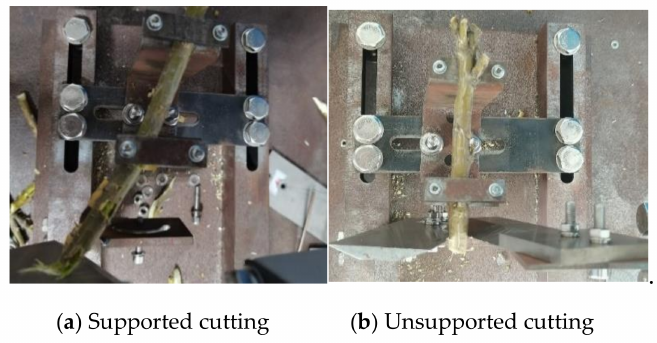
Figure 8. The state of the branch under different cutting methods.